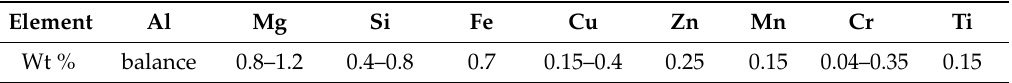
Table 4. Chemical composition of aluminium alloy 6061.